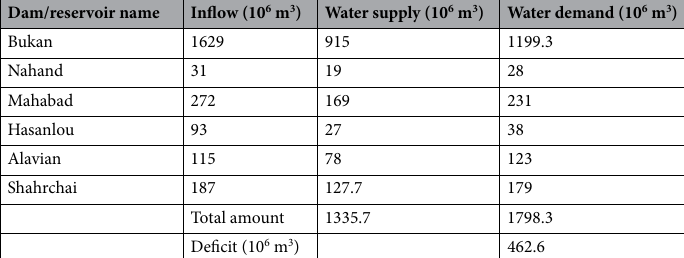
Dam/reservoir name